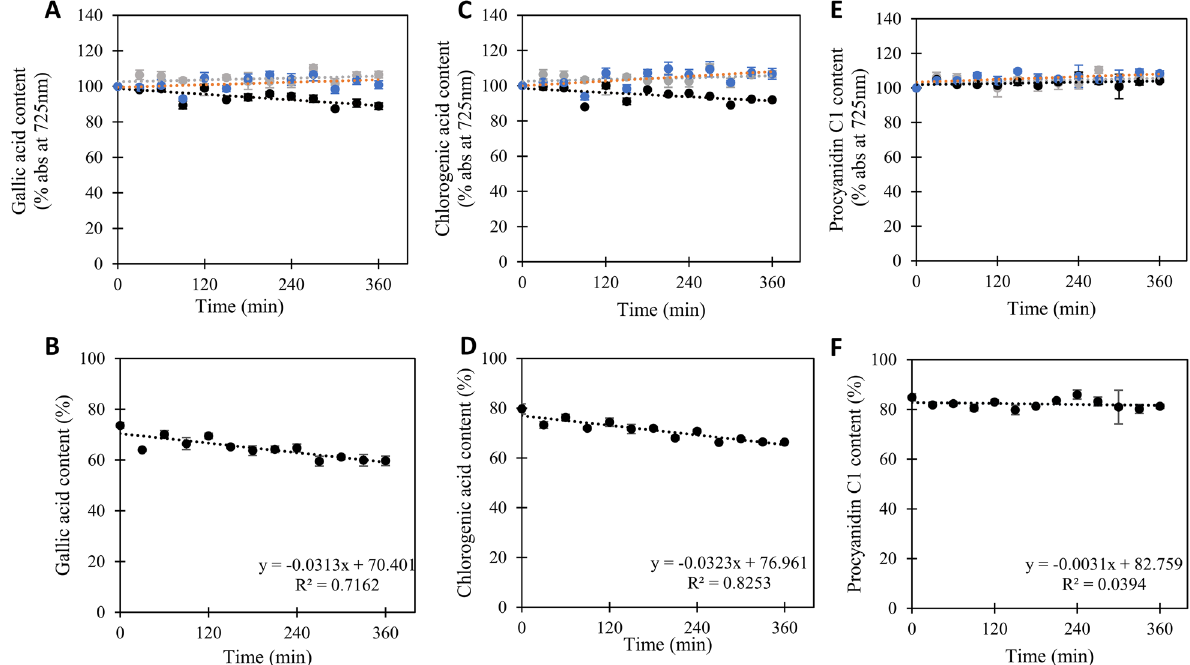
Fig. 6 Biocatalytic reduction of phenols in pure phenolic compounds using BLC23O. Phenolic content in samples was evaluated in the presence (black) and absence (blue) of BLC23O over time. An enzyme-only control sample was also assessed (grey). Reactions were initiated with the addition enzyme at 32.5 °C. Samples were taken in 30 min intervals and reacted with the Folin–Ciocalteu reagent. Time zero was set to 100% phenol and changes in absorbance at 725 nm plotted on a percentage change basis for A gallic acid, C chlorogenic acid and E procyanidin C1. The observed changes in phenol content of BLC23O-treated B gallic acid, D chlorogenic acid and F procyanidin C1 were quantified relative to untreated fractions. The data represent the mean and standard deviation ( n 3). Linear fits of the data and the corresponding equations and coefficients of = determination are shown. See also Additional file 1: Figure S4 for addition